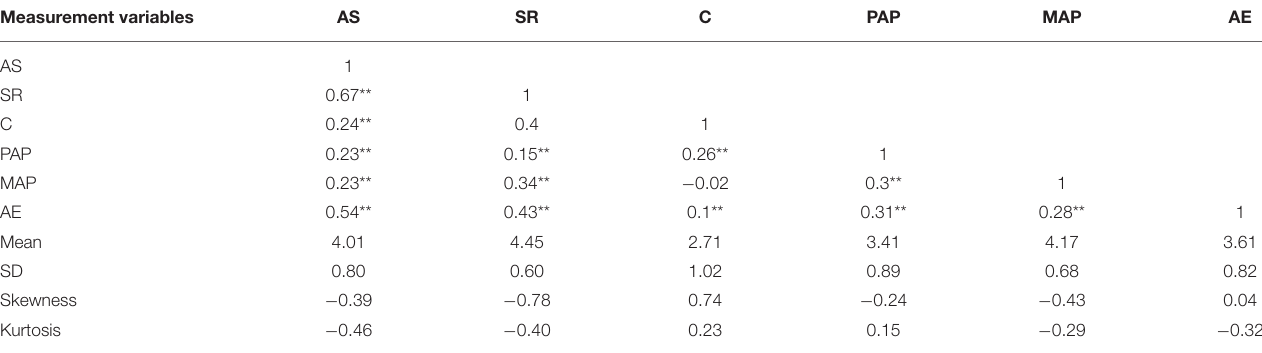
TABLE 1 | Descriptive statistics and bivariate correlations among the scales ( n = 632). Measurement variables